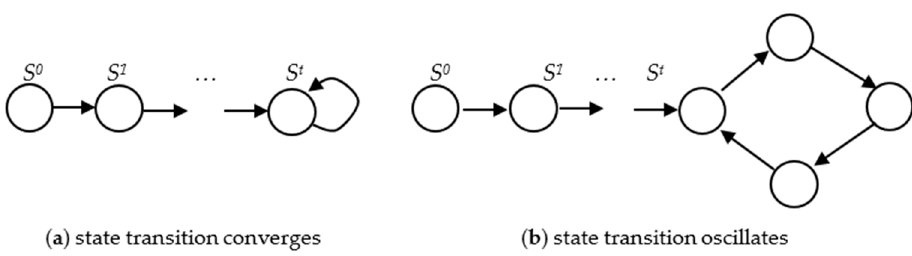
Figure 3. Examples of a state transition graph.